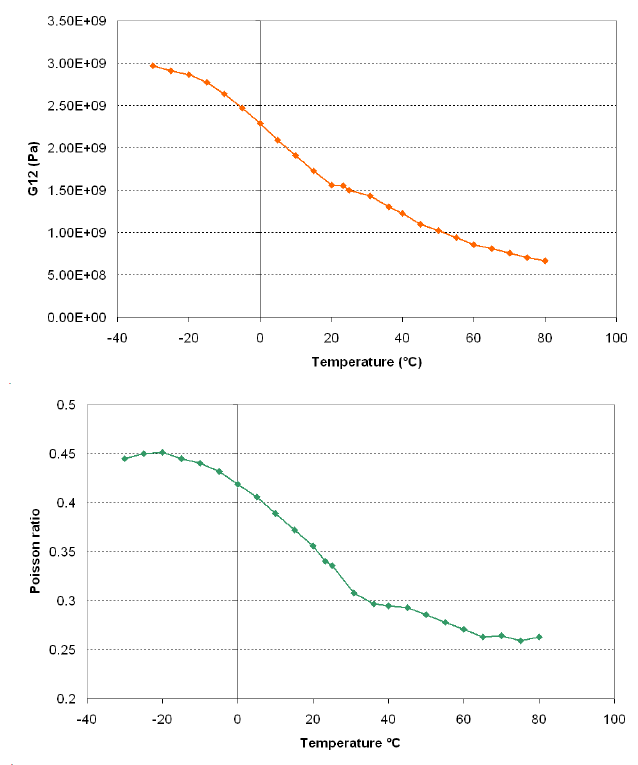
Fig. 7. Identified engineering constants as a function of the